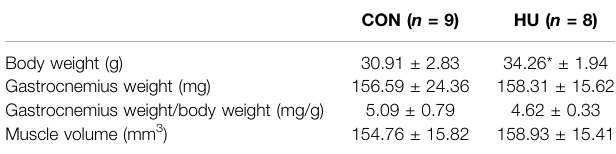
TABLE 3 | Metabolic index at rest and